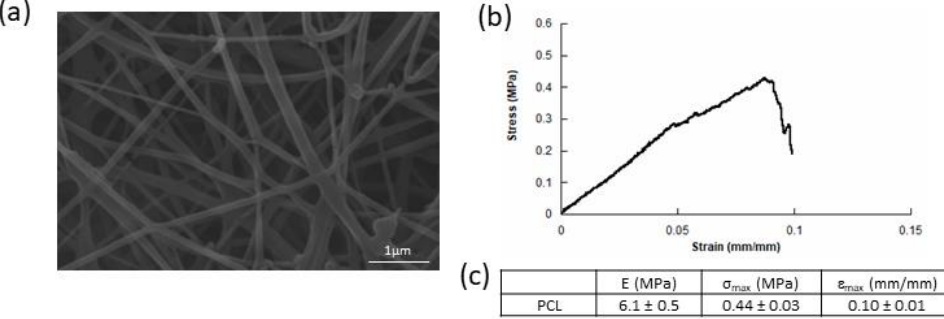
Figure 2. ( a ) Scanning Electron Microscope (SEM) micrographs of dry electrospun PCL without cells. ( b ) Stress-strain curve for electrospun PCL meshes. ( c ) Tensile tests on electrospun PCL meshes: modulus (E), maximum stress (σ max ), and maximum strain ( ε max ) reported as mean value ± standard deviation (SD).